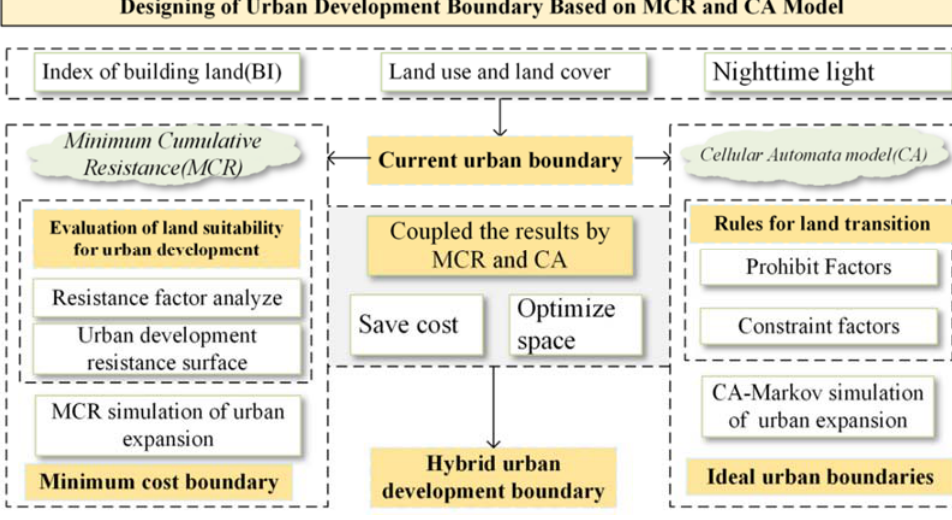
Figure 4. Research framework.